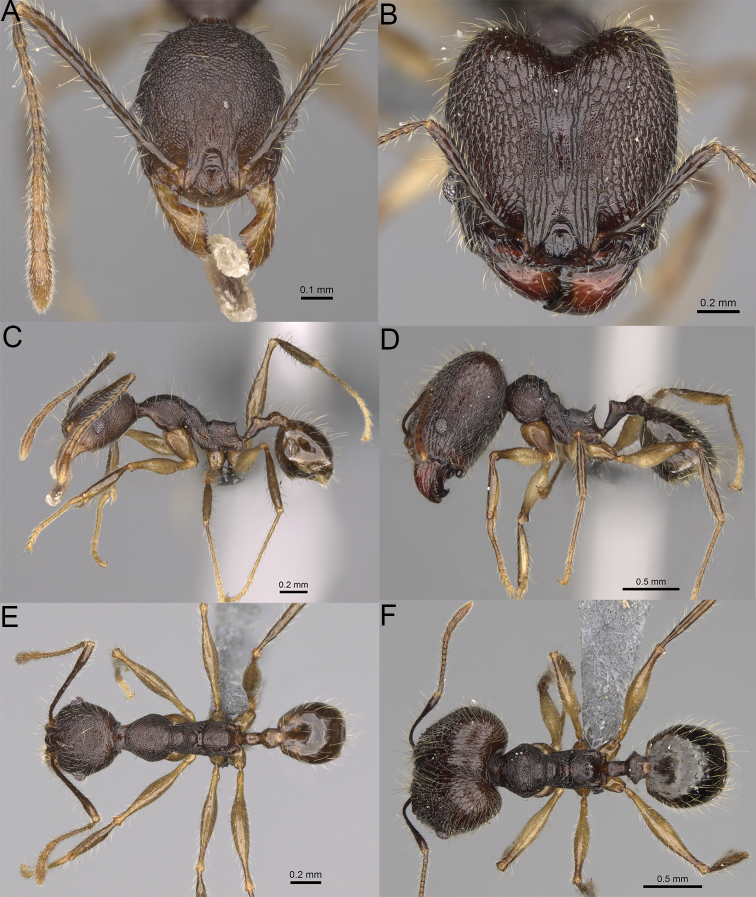
Pheidole
trichotos sp. nov., full-face view (A), profile (C), and dorsal view (E) of paratype minor worker (CASENT0923258) and full-face view (B), profile (D), and dorsal view (F) of holotype major worker (CASENT0788058).